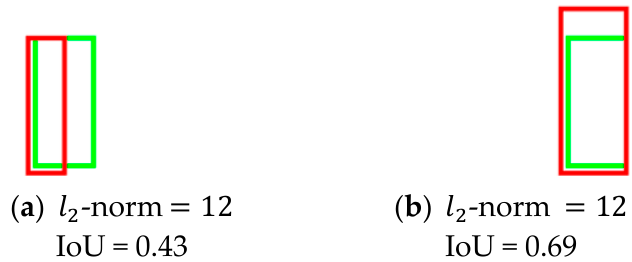
Figure 2. l 2 -norm distances and IoU values of detection box (red) and ground truth box (green). ( a ) As an example, when l 2 -norm is 12, the IoU of the two boxes is 0.43. ( b ) With the same l 2 -norm, the IoU of the two boxes is 0.69. A higher IoU value indicates better detection localization. Furthermore, illumination is a critical factor for detection performance. Since pho- tographs are captured under diverse exposure, including overexposure or heavily shaded areas, the illumination frequently influences the visibility of pedestrians in test